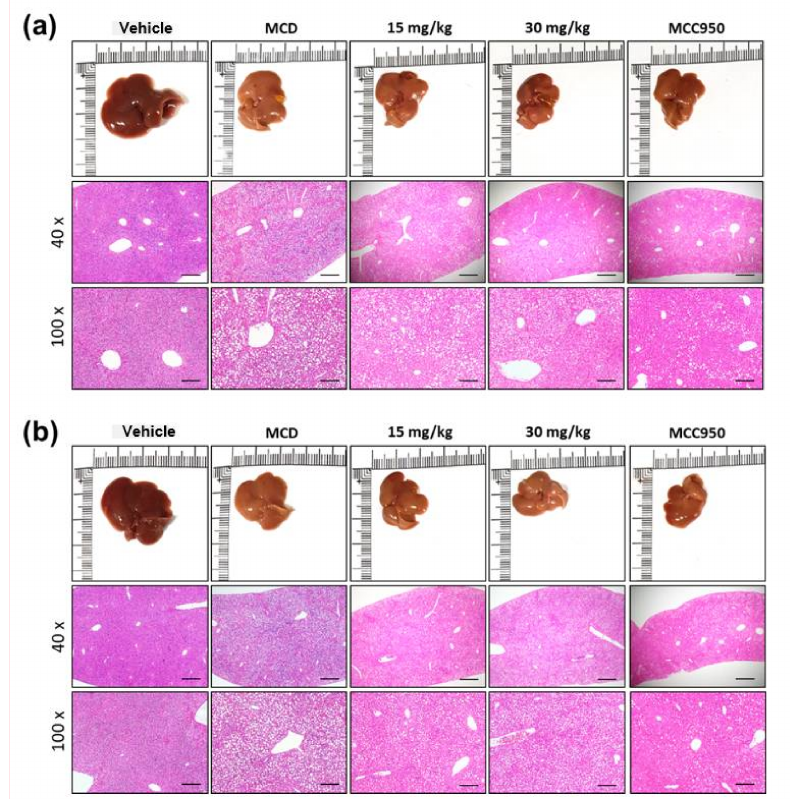
Figure 4. Alleviating e ff ect of Rg3 or Gyp LXXV on fatty liver and hepatitis in the MCD diet mouse model. Representative photographs of the fresh livers and histopathological haematoxylin eosin (H&E) staining of liver sections administered Rg3 ( a ) or Gyp LXXV ( b ) (15–30 mg / kg) are presented the middle panels with a 40 × magnification and a scale bar 500 µ m, and the lower panels with a 100 × magnification and a scale bar 200 µ